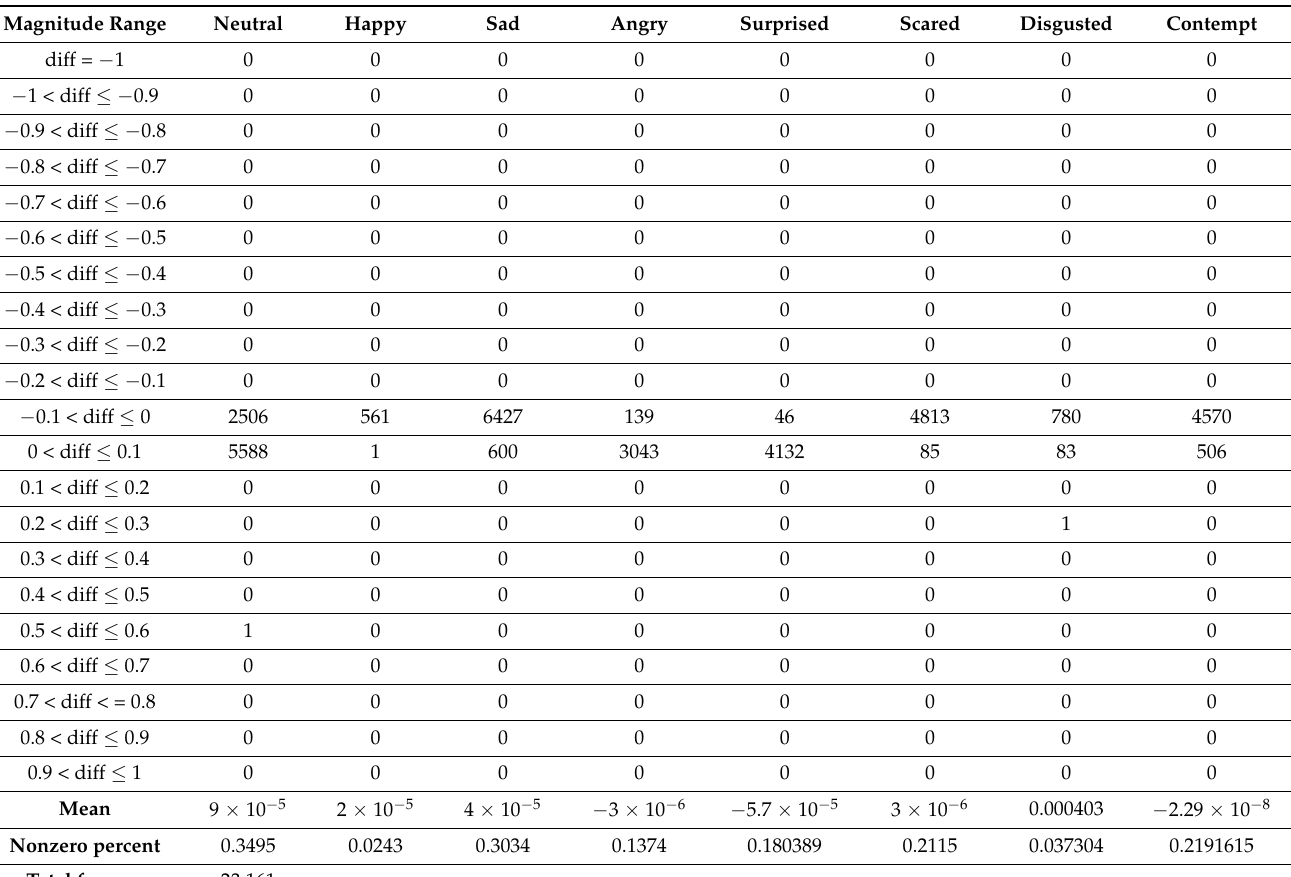
Table A5. Distributions of emotion intensity differences for Subject #65 (ASD) from test 2 –test 3 comparison. Subject #65 was the only participant whose number of differing data points increased from test 1 –test 2 to test 2 –test 3 comparison. Still, the corresponding distribution means are quite low in both comparisons (cf. Appendix A Table A4).